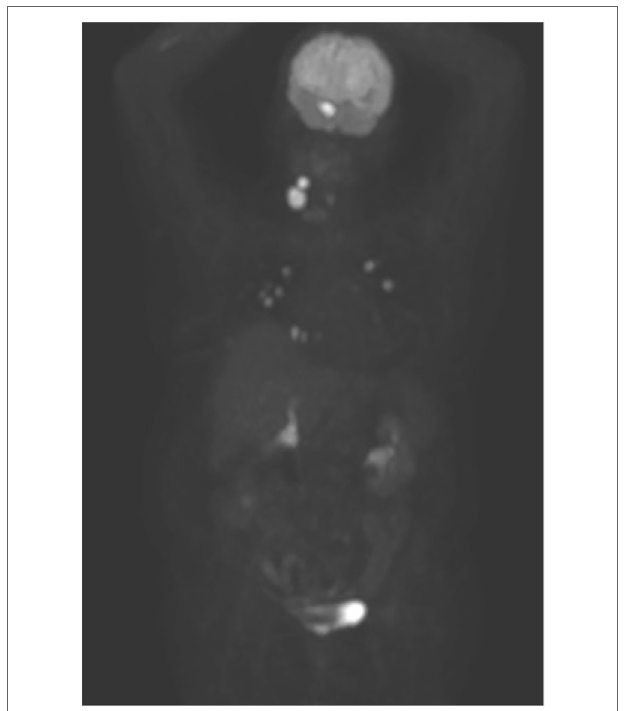
FiGURe 1 | 18 FDG PET/CT performed before lenvatinib administration. Besides the numerous bilateral lung metastases, note the intense uptake by two locally recurrent lesions in the neck and by the cavernous sinus